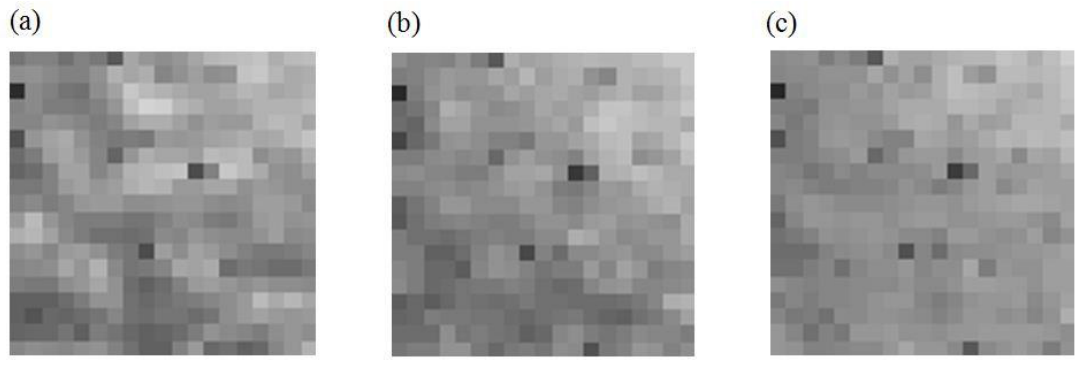
Figure 2. ( a ) Coarse sandpaper mouse sensor image; ( b ) Medium sandpaper mouse sensor image; ( c ) Fine sandpaper mouse sensor image. All images were obtained, using a 30 degree angled white LED illumination source, from the re-lensed mouse